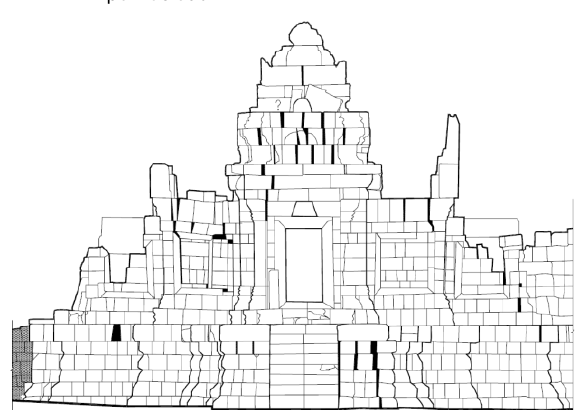
Figure 6. South elevation of the Outer South Gate of Ta Keo Temple, Angkor Monuments, Cambodia, measured drawing based on point cloud and